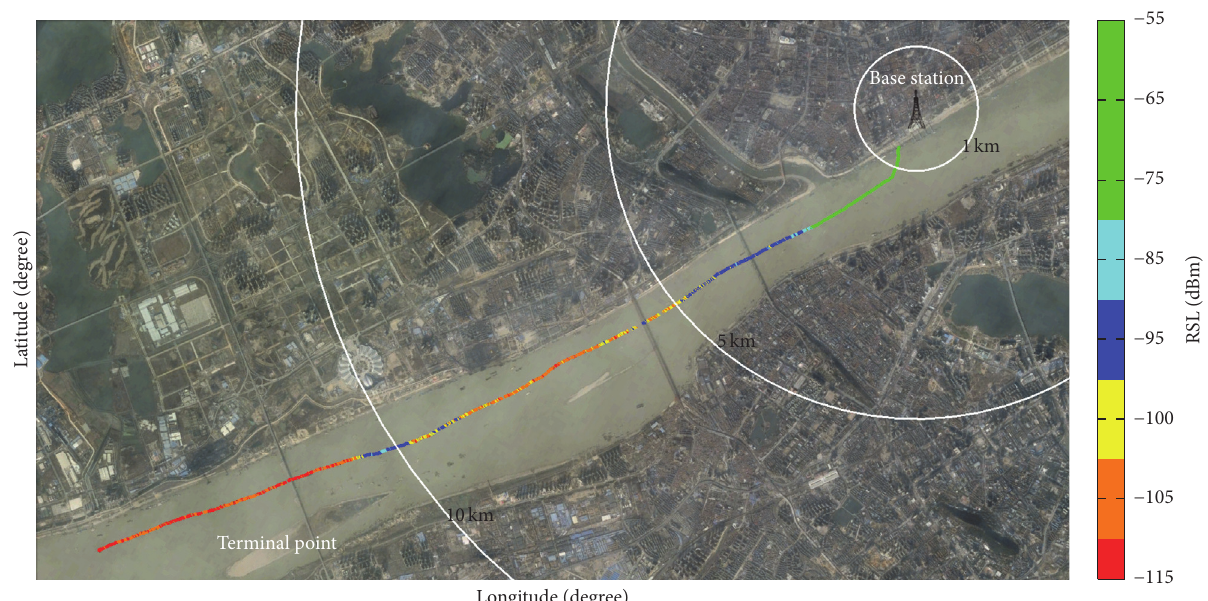
Figure 6: The route of measurement campaign 2 with large buildings between TX and